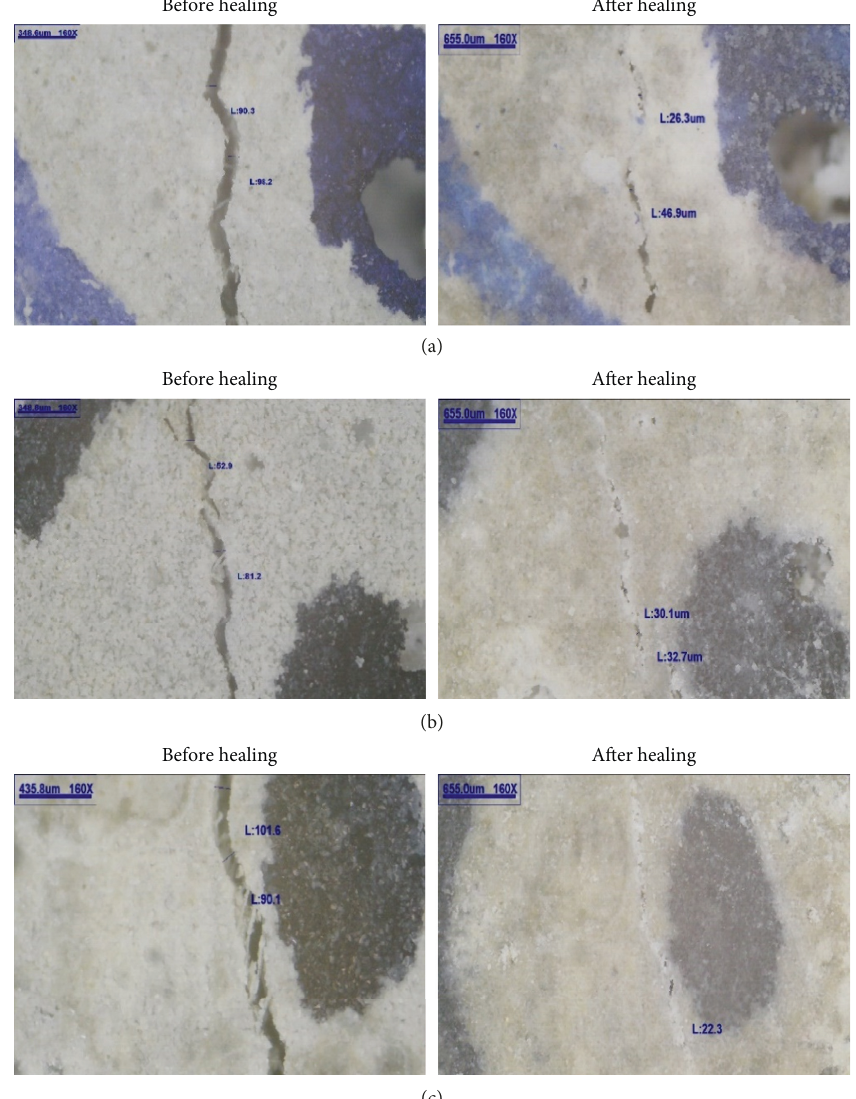
Figure 9: Microscopic observation of specimens before and after the healing period of 56 days in water immersion conditions: (a) OPC; (b) SH1; (c) SH2.